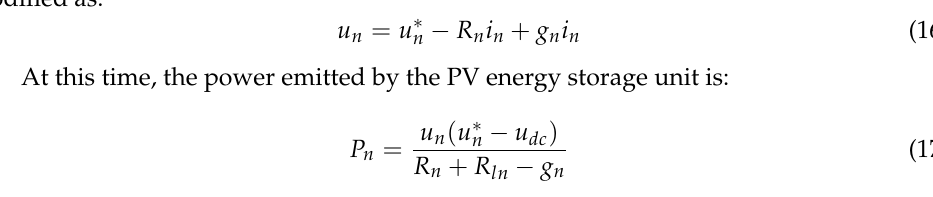
Figure 8. Illustrative diagram of the limitations of traditional droop control containing the differences between the two groups of DG systems.